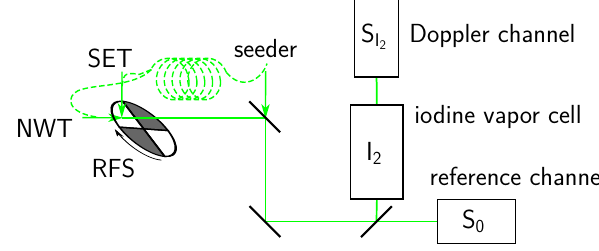
Fig. 2. Sketch of the DoRIS branch of the detection system. Dur- ing operation backscattered light from both telescopes (NWT, SET) is alternately coupled into the detection system using a rotary fiber selector (RFS); light from the stabilized seed laser enters through an additional entrance (solid line) after the RFS. Reference channel ( S 0 ) and Doppler channel ( S I ) consist each of three intensity cas- 2 Fig. 3. Modeled matrix of Doppler ratio as function of temperature caded detectors. For calibration measurements light from the seed and wind speed; dotted lines are isolines for 0.4, 0.5, and 0.6; dashed laser can additionally be coupled into the detection system through line indicates zero wind speed. The Doppler ratio is more sensitive the telescope entrances (dashed fibers). to wind speed than to temperature and not a symmetric function of wind